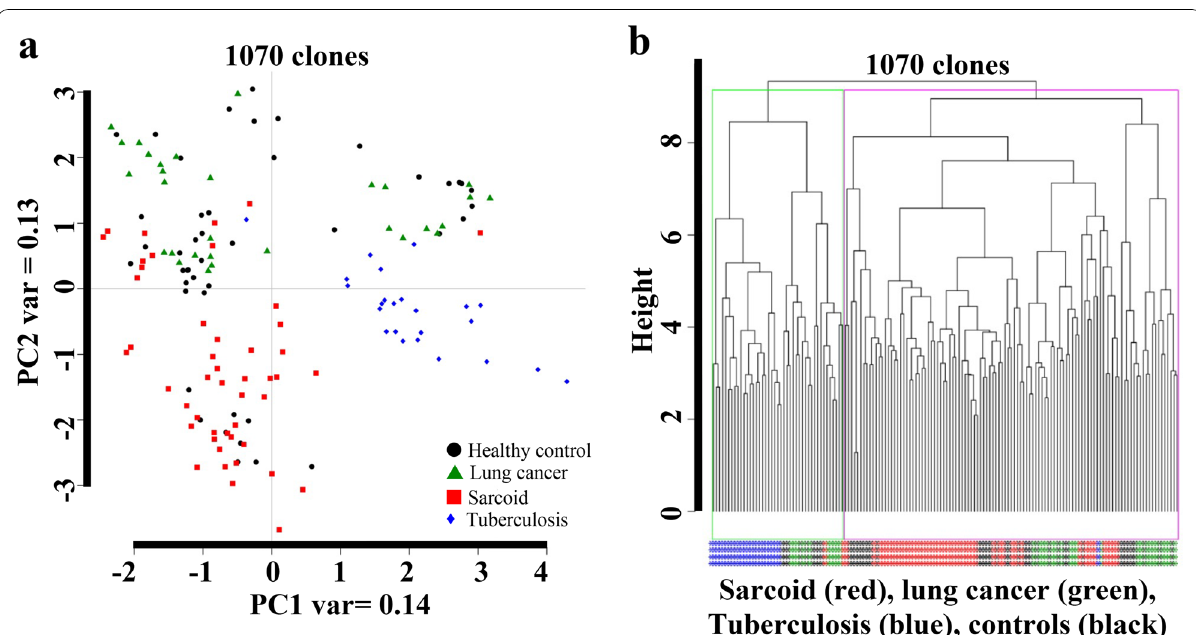
Fig. 1 PCA and Hierarchal clustering (option1). a PCA plot along PC1 and PC2 generated with 1070 clones of four groups: (1) healthy control samples; (2) Sarcoidosis samples; (3) TB samples; and (4) Lung cancer. Biomarker clusters along the PC1 explain a variance of only 14%, while the variance along PC2 was about 13%. b The hierarchal clustering was applied on the healthy controls, sarcoidosis, TB patients and lung cancer with 1070